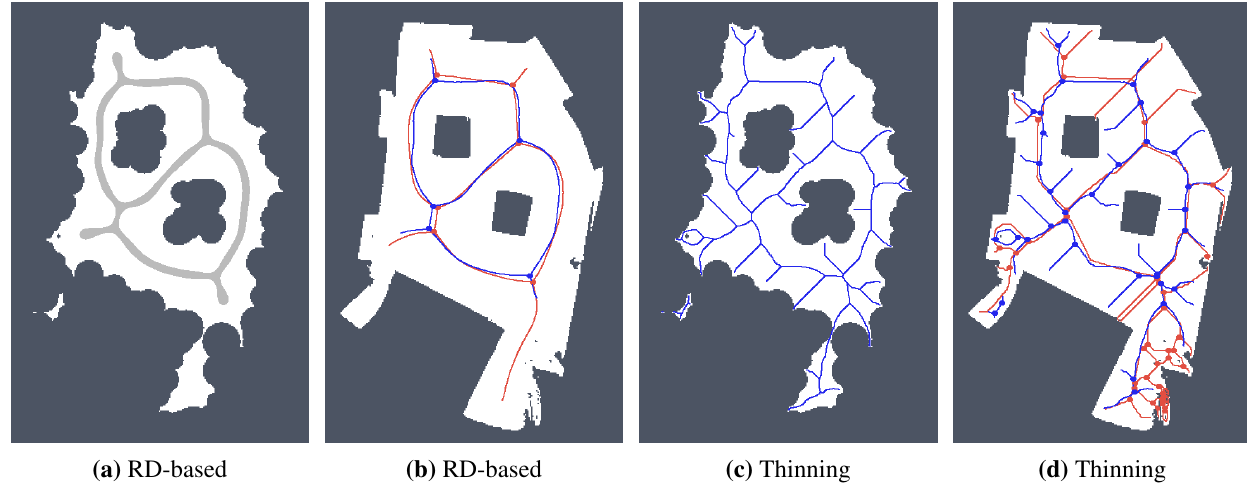
Figure 22. Determined skeletons and topological maps with highlighted junction places and leaves in the map cube with the noise level σ = 5 for the scaled map with 478 × 698 grid points: ( a ) RD-based Voronoi diagram; ( b ) and its corresponding skeleton superimposed on the skeleton determined in the noise-less map (in red); ( c ) Pruned GVG representing skeleton of the map determined by the thinning algorithm [12]; ( d ) and the corresponding skeleton superimposed on the skeleton determined in the noise-less